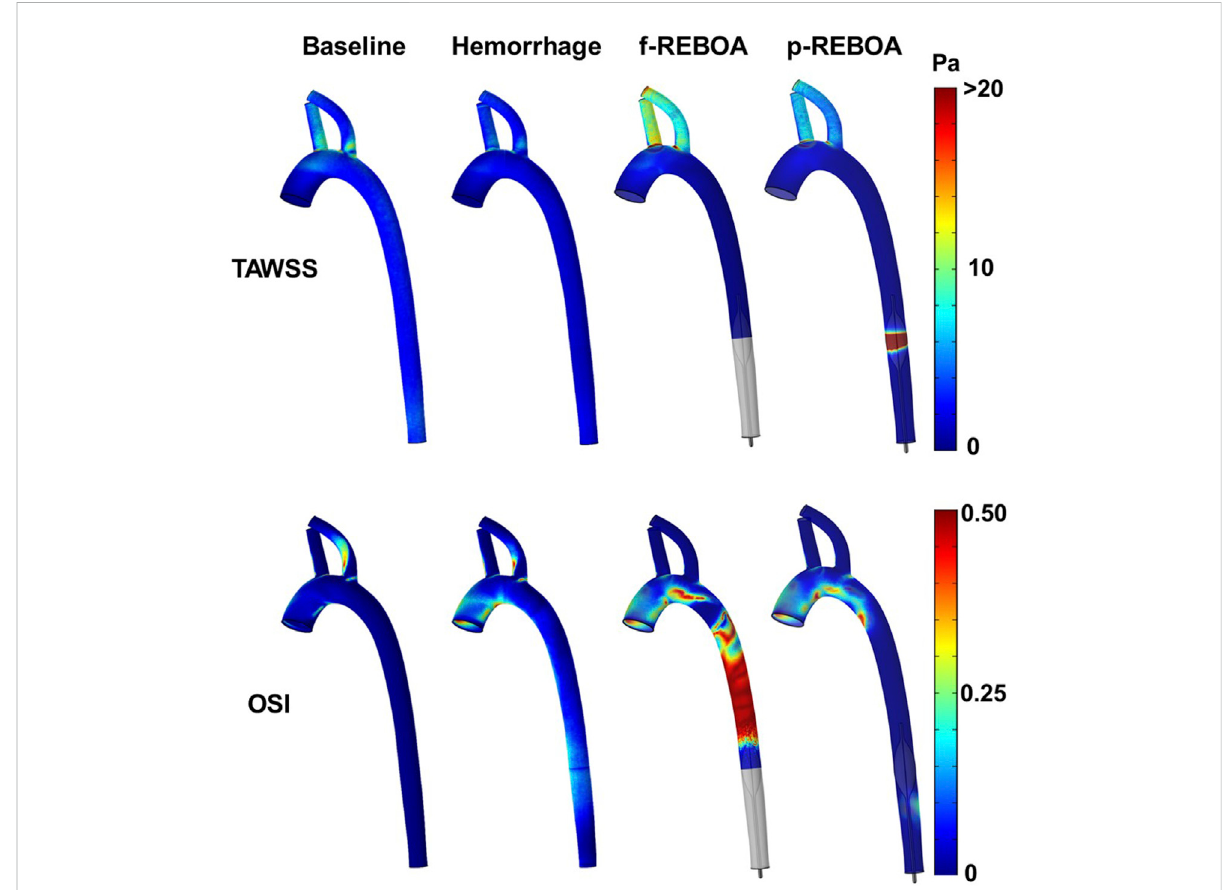
FIGURE 6 Shear stress and oscillatory shear index from the CFD simulations. Three-dimensional distribution of time averaged wall shear stress (TAWSS, top) and oscillatory shear index (OSI, bottom) over a cardiac cycle for baseline, hemorrhage, f-REBOA and p-REBOA are illustrated. Regions of high shear are observed around the p-REBOA. Signi fi cant fl ow oscillations are observed in the aorta during